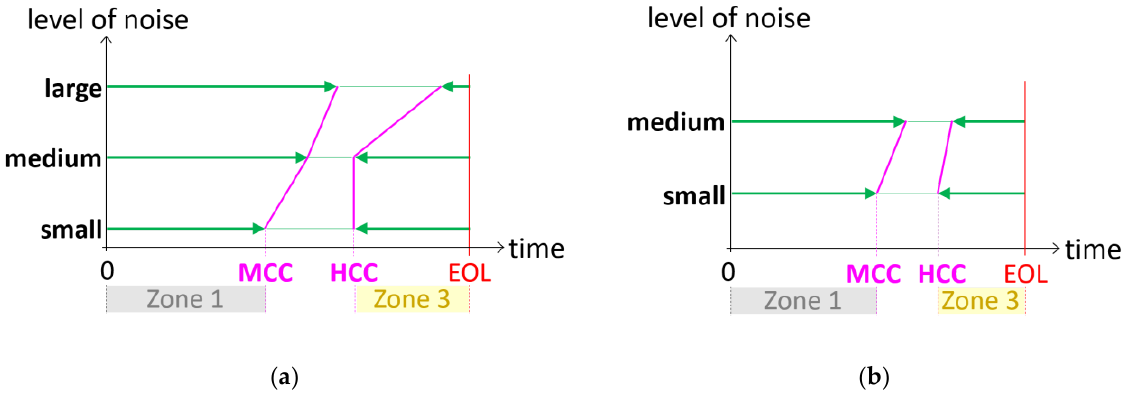
Figure 11. Changes of credibility criteria according to the level of noise. ( a ) Crack growth problem, ( b ) battery degradation problem.